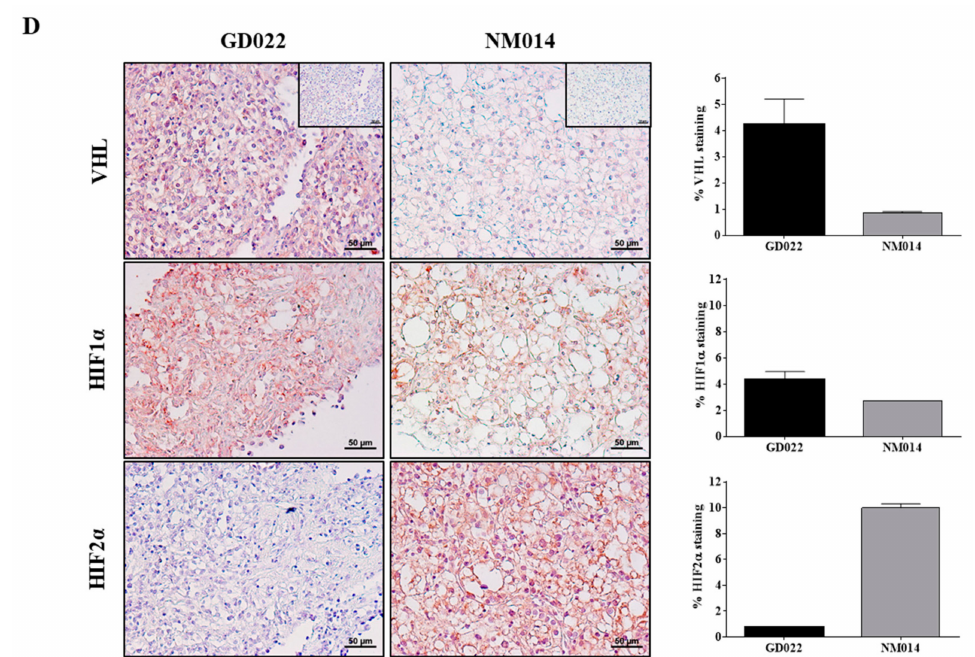
Figure 4. Treatment of slice cultures from human renal tumors. Tissue slice cultures from human renal tumors were treated for 48 h with a panel of drugs (10 µ M each) and cell viability assayed as in Figure 3A. ( A ) Intra-tumor heterogeneity. Two fragments A and B of the same tumor (NM014) were analyzed for their sensitivity to indicated drug treatments. Mean DMSO was normalized to 1 to compare the two fragments of NM014. The y -axis represents the ratio of the percentage of dead cells in the di ff erent groups divided by the corresponding value in the DMSO-treated-PDTSC. Cell death measurement in fragment A (black bars) from NM014 shows significant di ff erences between DMSO versus the combination (GDC / SRC, * p < 0.5), pazopanib (PAZO, ** p < 0.01) and temsirolimus (TEM, * p < 0.5) but not versus sunitinib (SUN). The same analysis of fragment B (white bars) from the same NM014 tumor, shows similar profile except for sunitinib that in this case induced significant cell death (SUN, **** p < 0.0005). ( B ) Apoptosis and proliferation assays. Representative pictures of tumor slices from fragment B of NM014 treated for 48 h with DMSO ( upper panels ) or 10 µ M sunitinib (SUN, lower panels ) and stained with Cleaved-Caspase-3 ( left panel ) or with anti-PCNA antibody ( right panel ). The PCNA stain identifies cells that are proliferating while the Cleaved-Caspase-3 stain shows cells undergoing apoptosis. The percentages of PCNA and Cleaved-Caspase 3 positive cells were plotted below each set of pictures. Scale bars, 20 µ m. Negative controls (no primary antibody) are shown in insets. ( C ) Inter-tumor heterogeneity. Four di ff erent tumors were treated and analyzed as in Figure 3A showing distinct drug sensitivity profiles. Each color represents one patient tumor (Yellow, NB029; Blue, YL024; Green, NM014; Purple, MD034). ( D ) VHL and HIF expressions. Representative pictures of two untreated tumor slices GD022 and NM014 stained with anti-VHL, anti-HIF1 α or anti-HIF2 α antibodies. Scale bars, 50 µ m. For each staining, images taken from five independent areas of a tumor slice were quantified with ImageJ and plotted as percentage of specific staining relative to tumor area (respective right